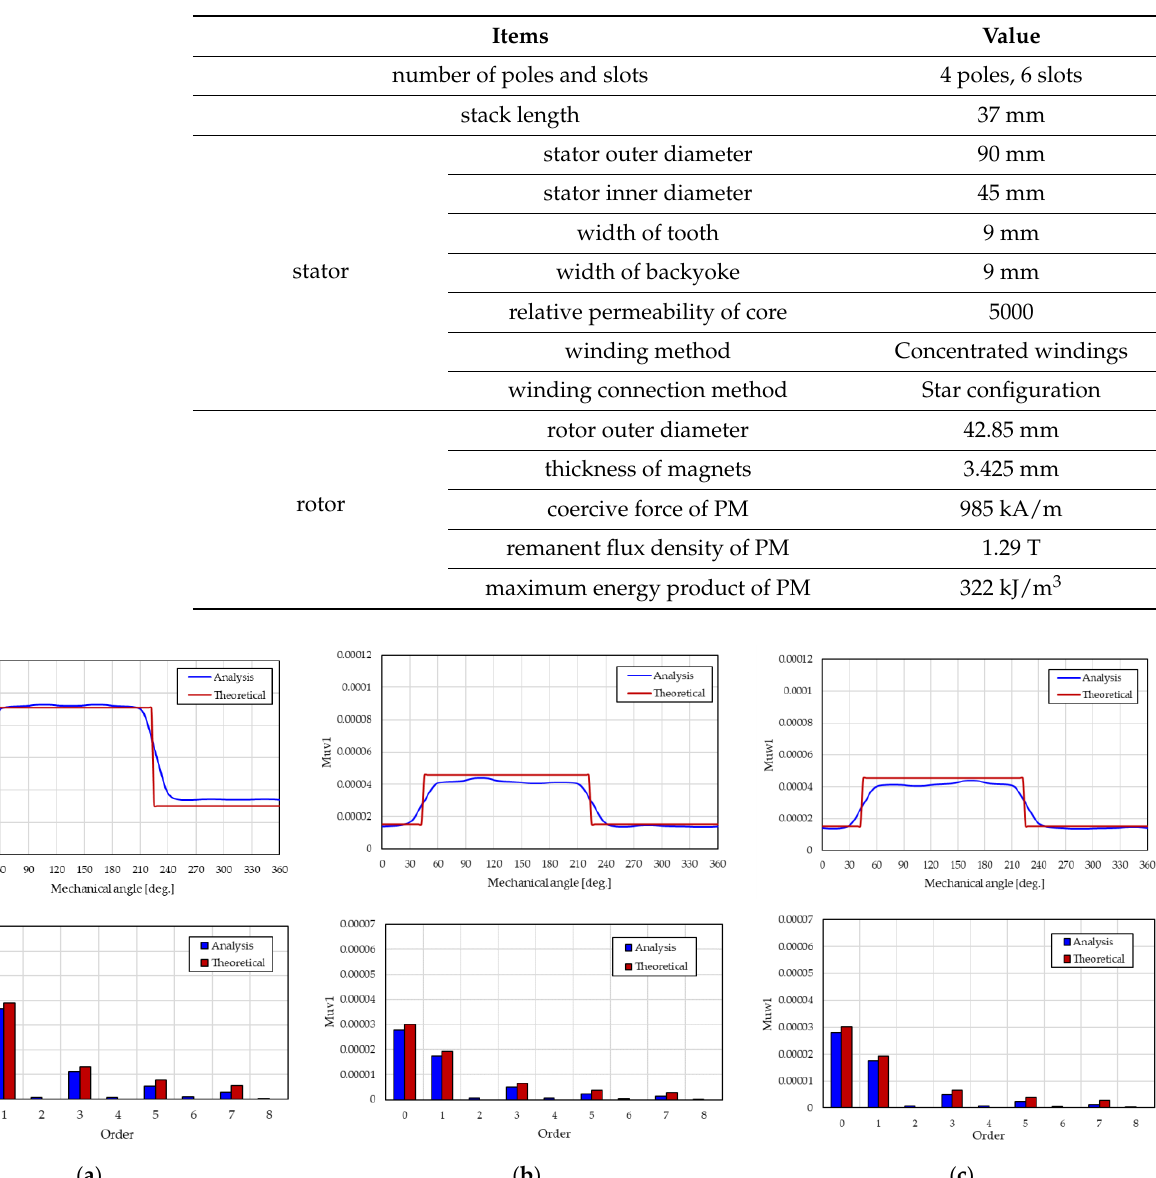
Table 1. Specifications of a novel consequent-pole PM motor.